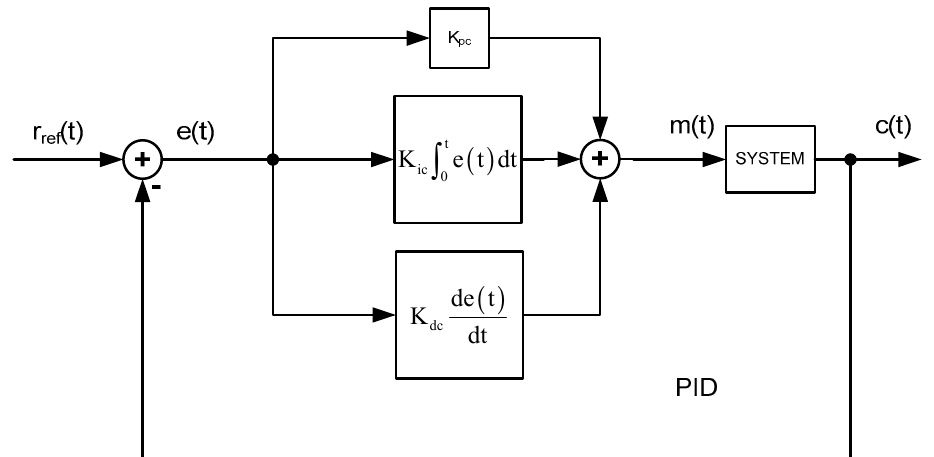
Figure 8. Analog Figure 8 . Analog PID.